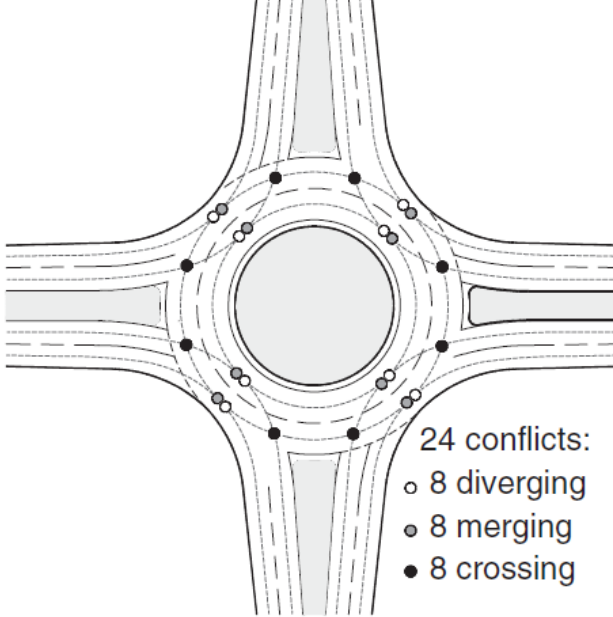
Figure 2. Conflict points in a standard roundabout